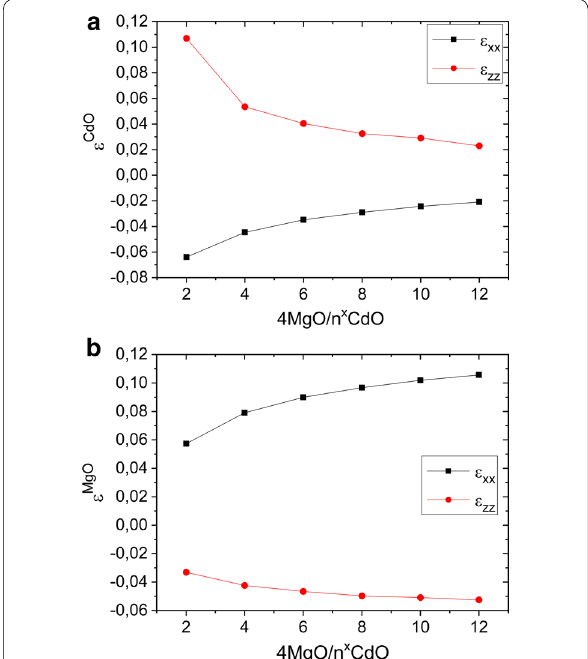
Fig. 7 Calculated strain conditions for 4ML of MgO and various numbers of CdO monolayers structures: ( a ) in-plane (epsilon xx) and out-of-plane (epsilon zz) strains in CdO; ( b ) in-plane and out-of-plane strains in